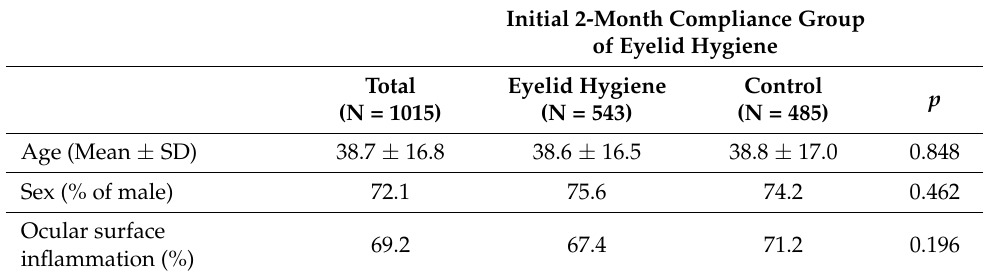
Table 1. Baseline characteristics of the study